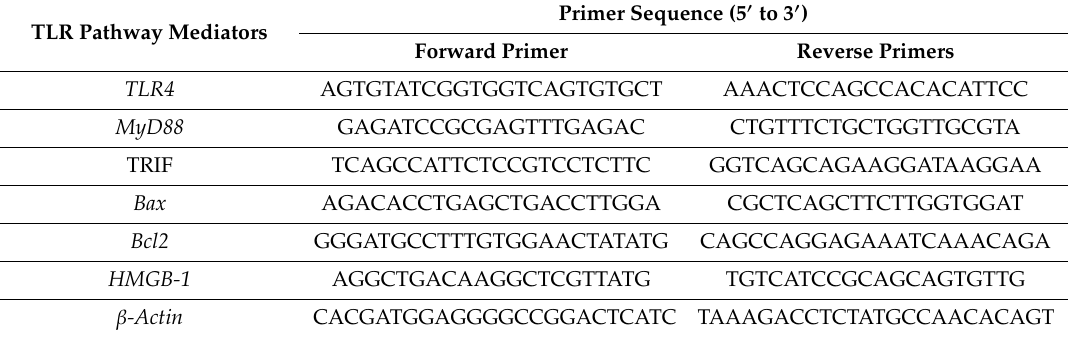
Table 1. Primers sequence used for real-time PCR of toll-like receptor (TLR) pathway gene expression. TLR Pathway